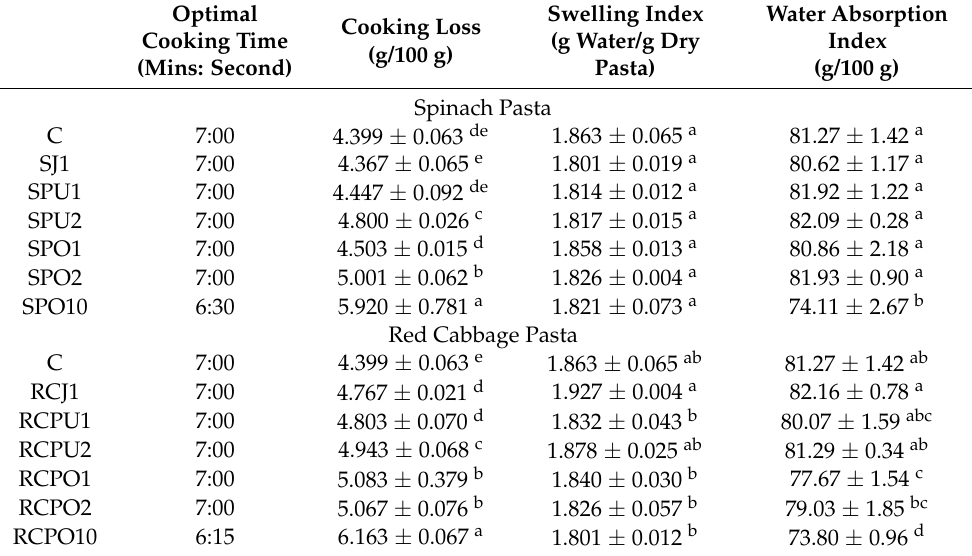
Table 3. Cooking performance of vegetable